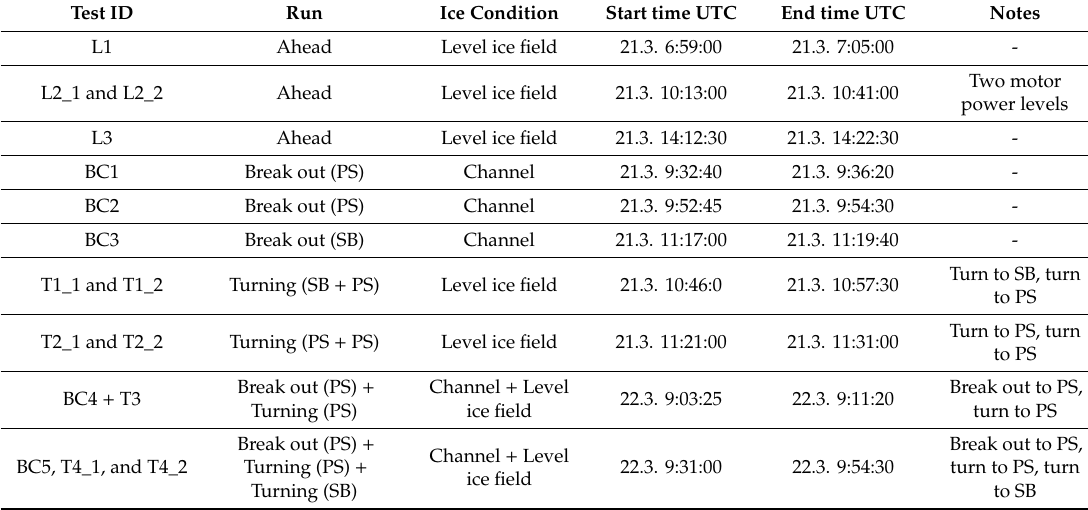
Table 2. Conducted maneuvering and straight-ahead tests. SB and PS refer to starboard and port side,